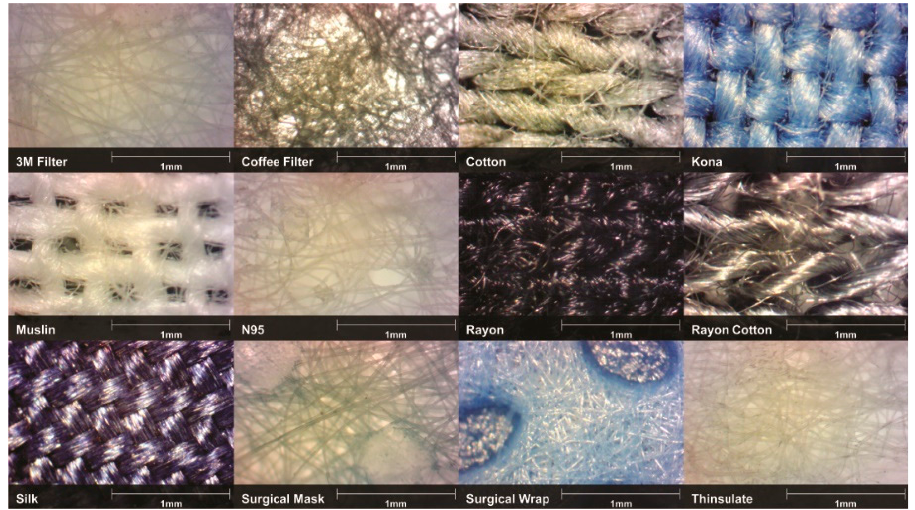
Figure 1. Microscopic images of the tested materials. Photos are taken at 2× magnification and are shown with a 1 mm scale.